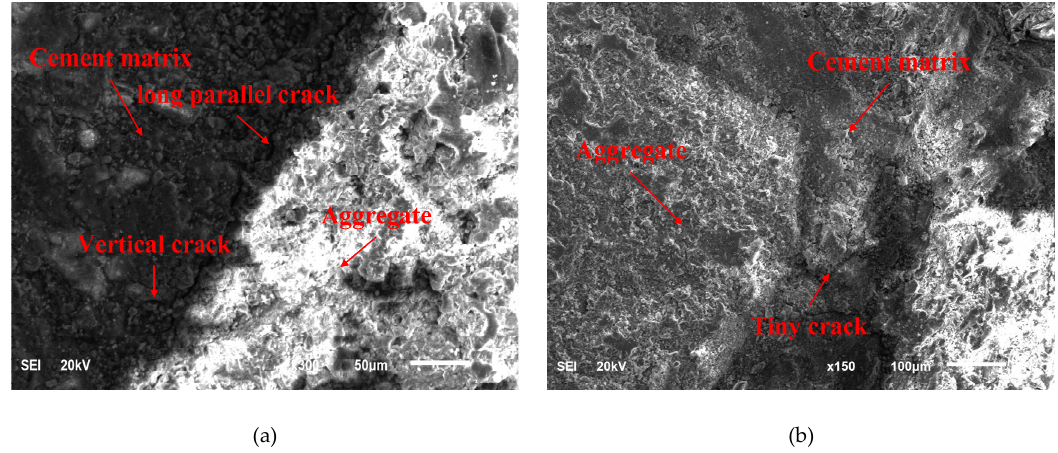
Figure 9. Scanning electron microscope (SEM) image of interface between cement matrix and aggregate: (a) MC, (b) SMC.